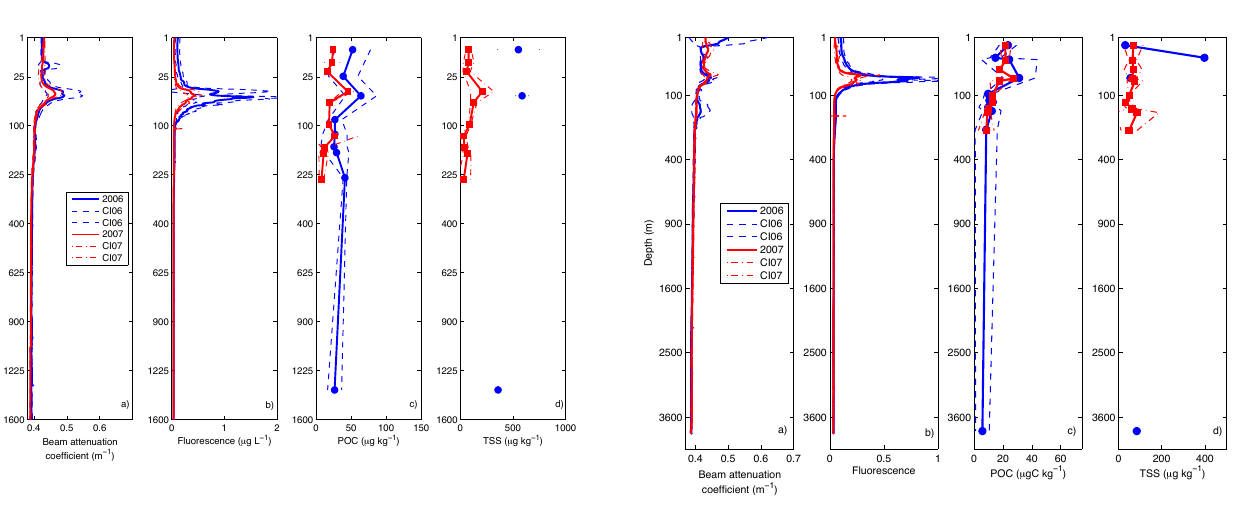
Fig. 5. As in Fig. 2 but for the interior of the Canada Basin. The upper 3800m are shown to include all attenuation features and bot- tle samples. The scales on the horizontal axes are half of those in Figs. 2–3.